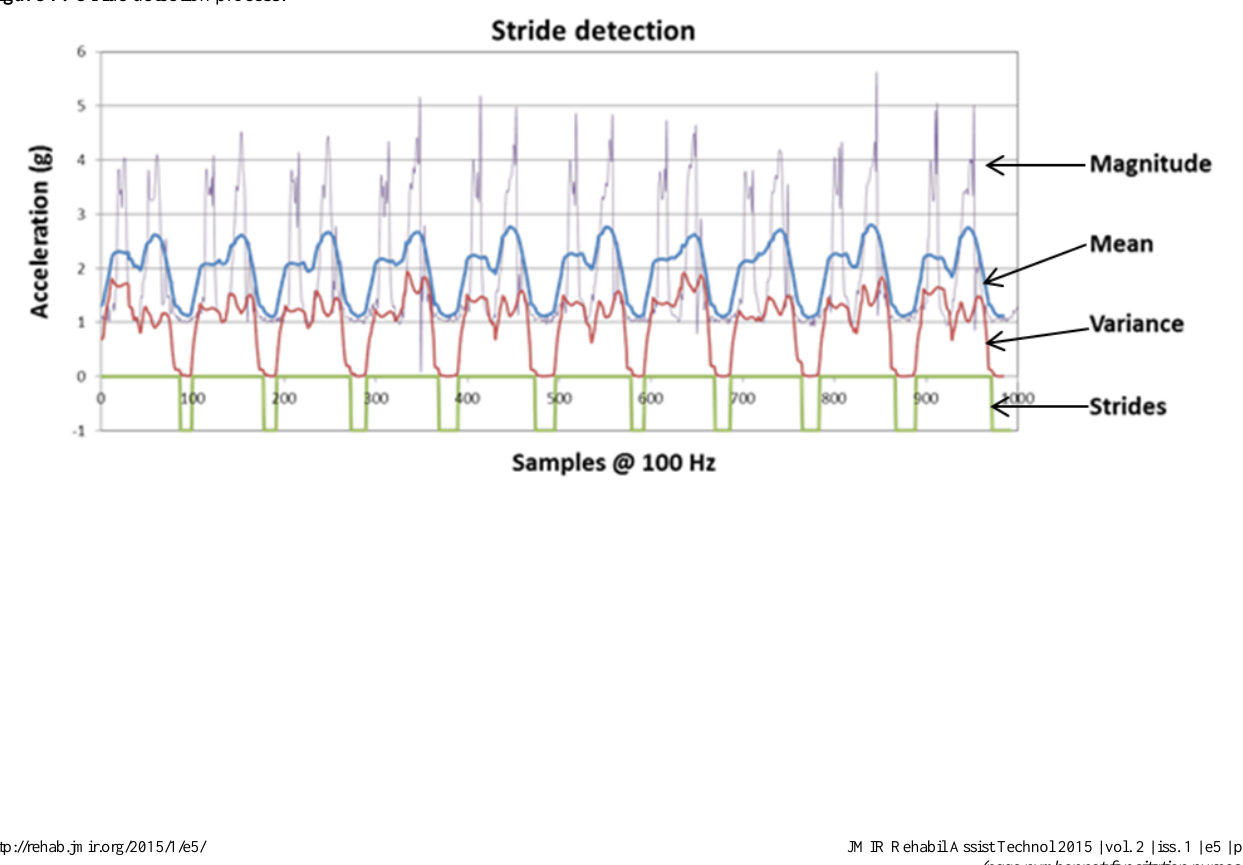
Figure 7. Stride detection